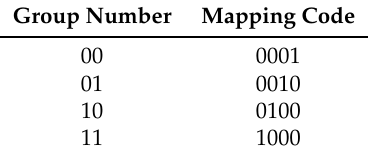
Table 2. Mapping